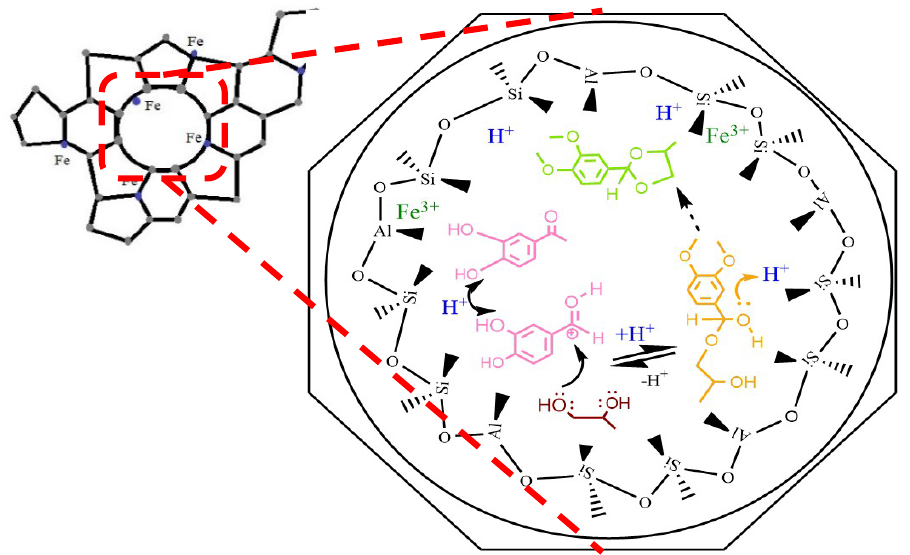
8 of 13 Table 2. Textural properties of aluminosilicate and ZSM-5 catalyst.